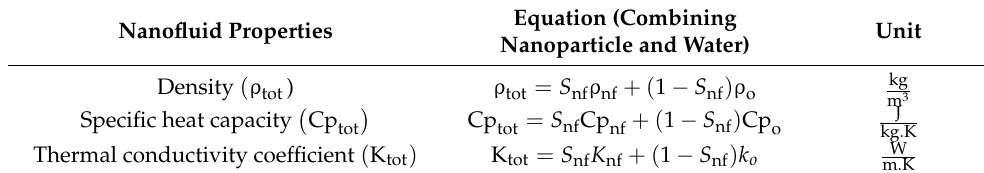
Table 8. Total characteristics that may be used in the energy equation.